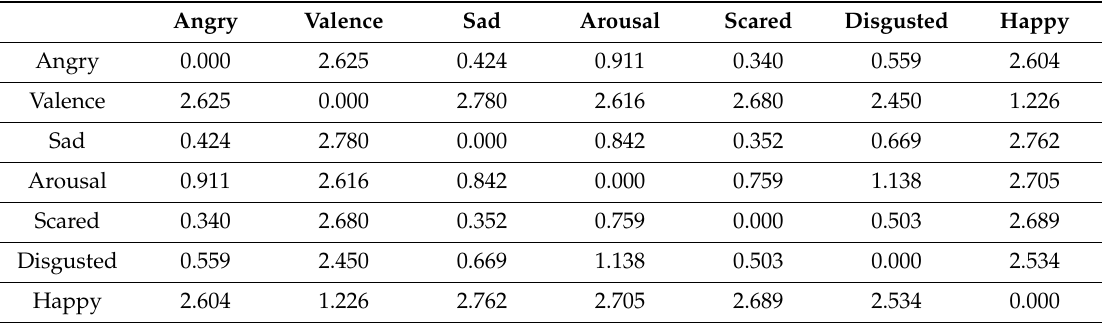
Table 9. Table of proximities of potential housing buyers’ emotions, valence, and arousal for Multidimensional